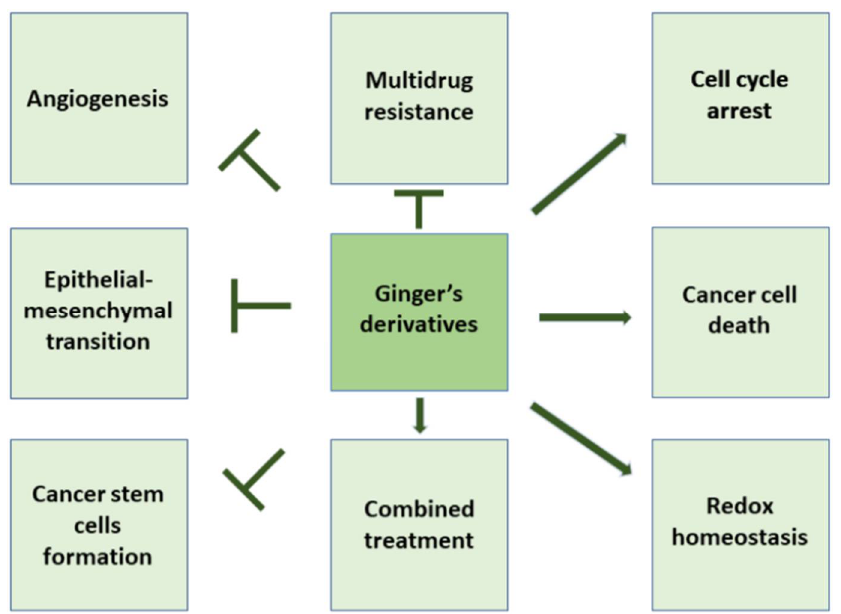
Figure 2. Schematic anti-cancer action of ginger and its phenolic derivatives. This natural compound reduces cancer cell proliferation, arrests cell cycle, causes an imbalance in cellular redox homeostasis, and induces cell death. Additionally, ginger derivatives inhibit angiogenesis, EMT, and CSCs. Furthermore, they decrease multidrug resistance and enhance chemopreventive effects.